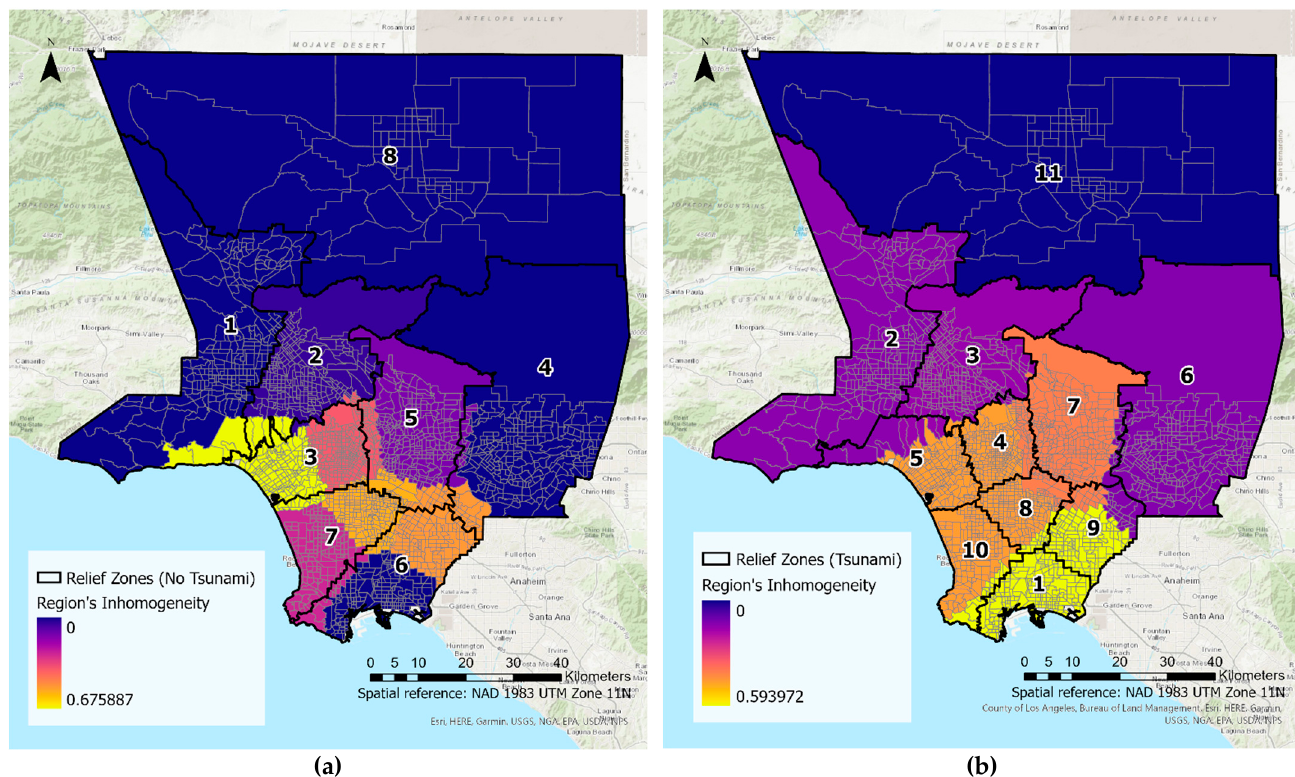
Figure 7. ( a ) Suitability Mean and ( b ) Total population by Zone in Tsunami Scenario. The overall similarity between relief zones for both of the scenarios are compared with the spatial V-measure. A V-measure of 0.89 indicates two relief zone maps are highly associated. The local differences between relief zones are depicted in Figure 8. Blue indi- cates low inhomogeneities (high degree of similarity), while yellow stands for high inho- mogeneities (low degree of similarity) between two scenarios.